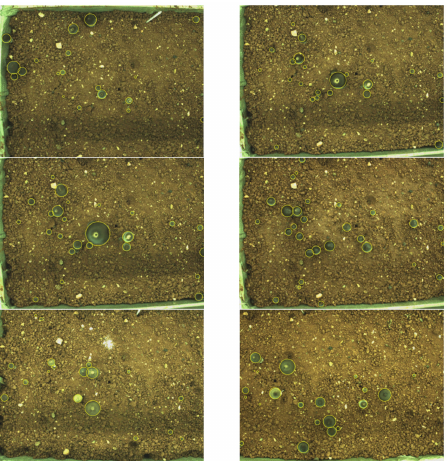
Figure 11. Using the proposed algorithm (ours) to fit mushroom circles of the entire